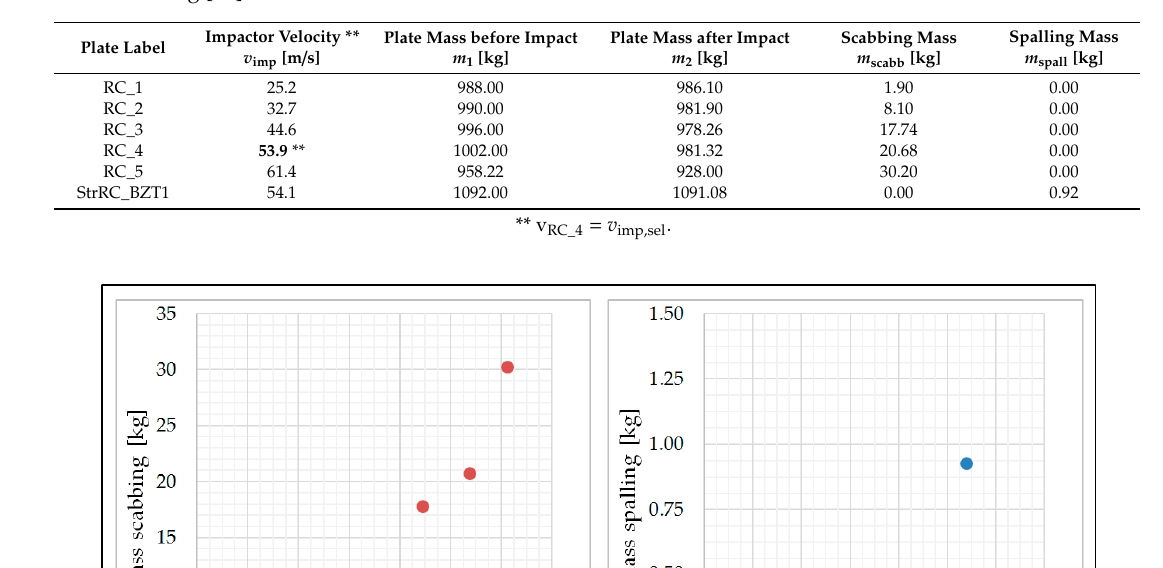
Table 3. Masses of the plates before and after the experiment and masses of scabbing / spalling failure; M. Hering [17].